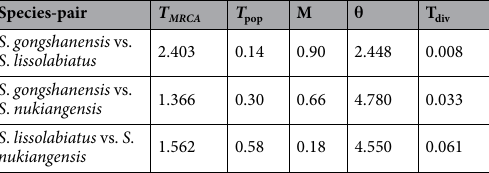
Species-pair T MRCA